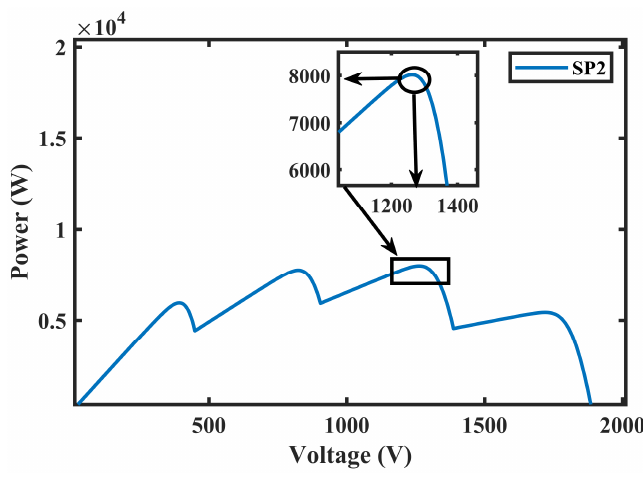
Figure 12. Voltage and power at SP2.